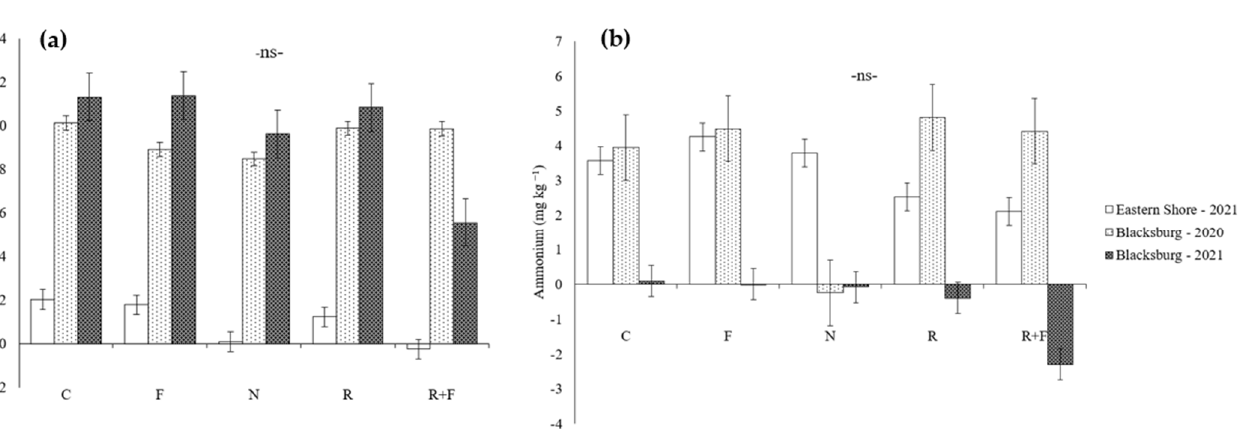
Figure 1. ( a ) Average difference in soil nitrate, from planting date until harvest, across treatments at each location. ( b ) Average difference in soil ammonia, from planting date until harvest across treatments at each location, at harvest. Treatments are labeled as follows: C = control, F = Arbuscular Mycorrhizal Fungi , N = Urea fertilizer, R = Bradyrhizobium spp. , R + F = Dual inoculation with Bradyrhizobium spp and Arbuscular Mycorrhizal Fungi. Treatments connected by different letters are significantly different at α = 0.10 according to Fishers protected LSD. (n = 75). ( a , b ) are denoted by “ns”, meaning treatment differences within each location are not significantly different.